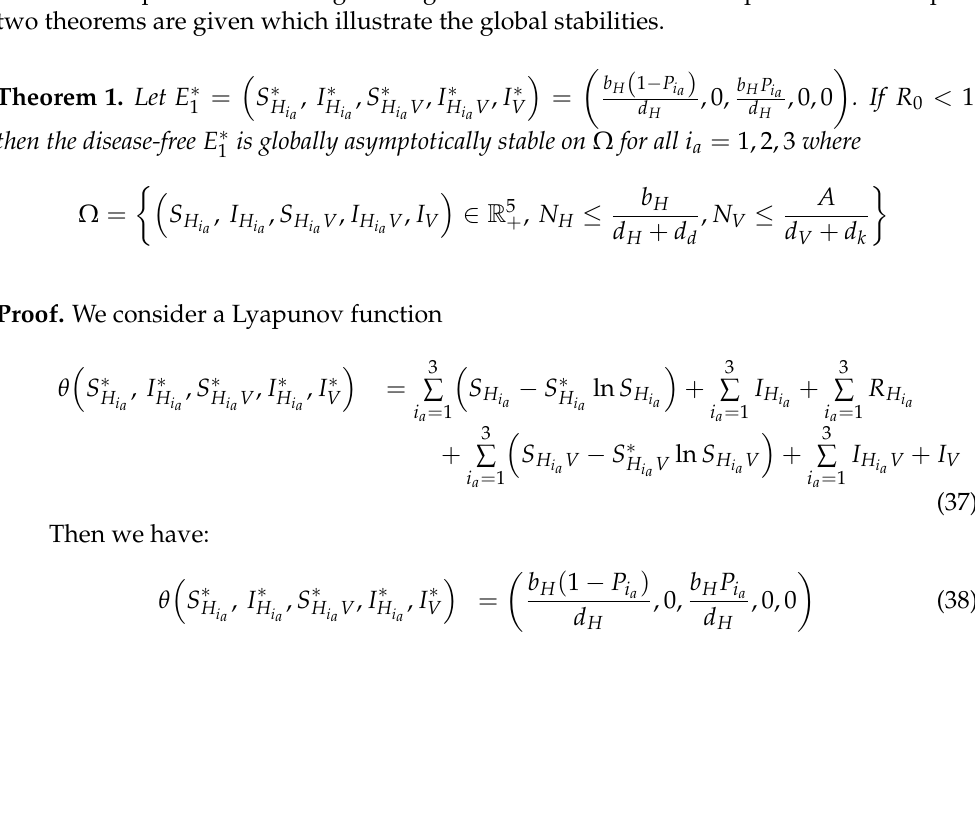
1 R < , then the disease-free 0 1,2,3 i = a